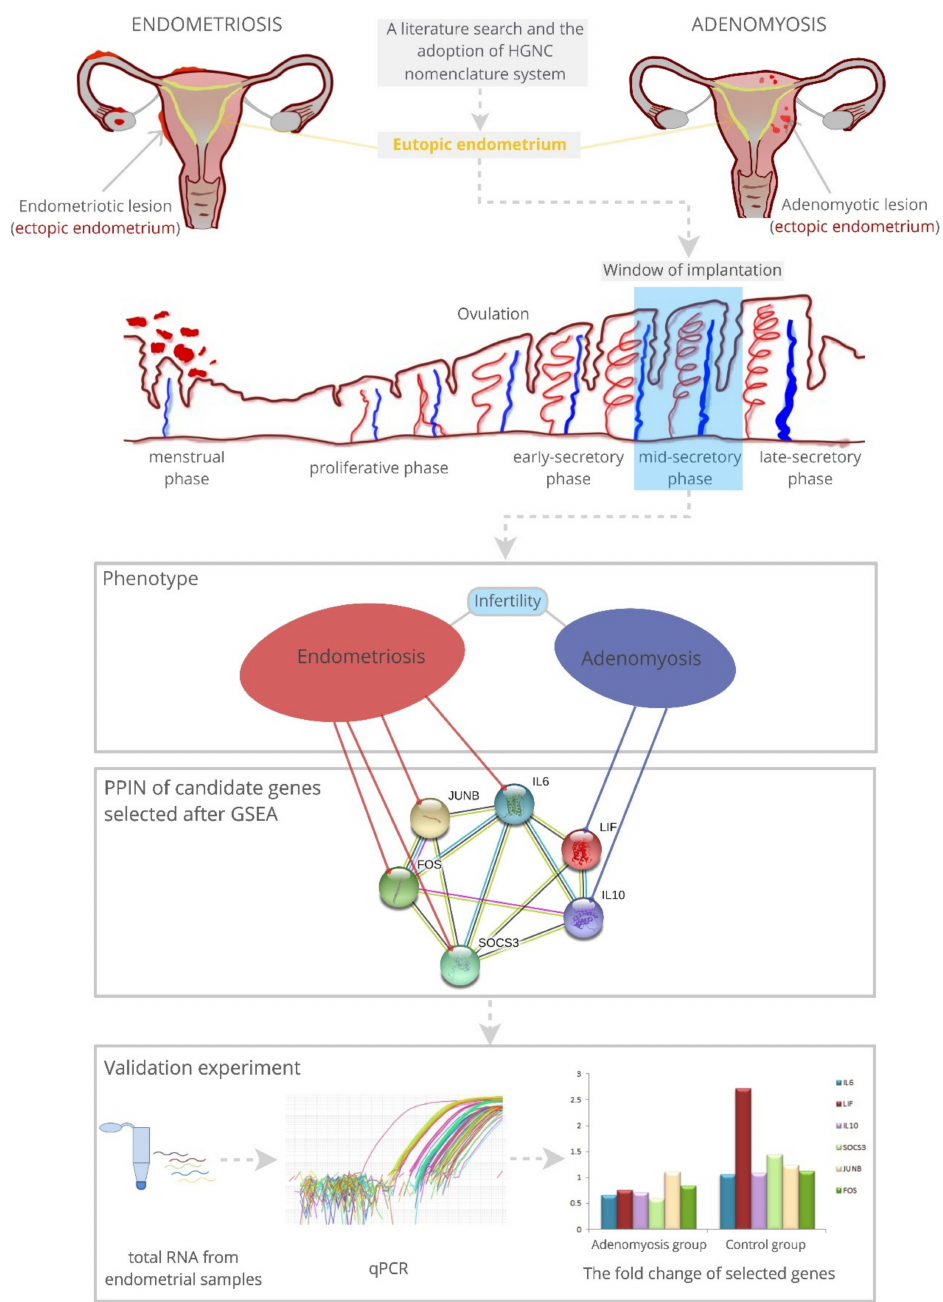
Figure 1. Graphical abstract of the study. Literature screening and HGNC nomenclature provided genes associated with endometrial receptivity that were further analysed for enriched pathways. Six candidate genes for experimental validation in adenomyosis were prioritised. Two selected genes originated from the adenomyosis group of 42 genes, and four from the endometriosis group of 173 genes. Protein–protein interaction network (PPIN) of selected genes is visualised using STRING database. Candidate genes were further validated in endometrial biopsy samples collected during window of receptivity in women with and without adenomyosis. Legend: GSEA = gene set enrichment analysis, STRING = Search Tool for the Retrieval of Interacting Genes / Protein. PPIN = Protein–protein interaction network, HGNC = Hugo Gene Nomenclature